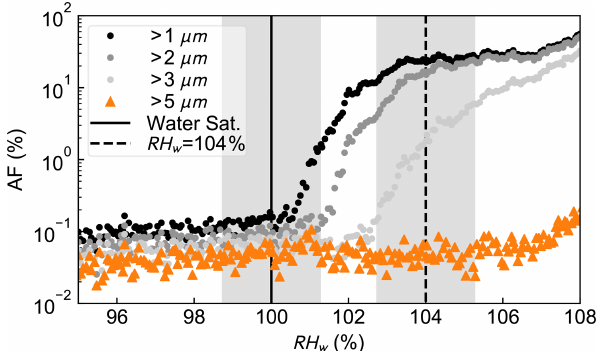
Figure B1. AF as a function of RH w at − 30 ◦ C for 200nm am- monium nitrate aqueous droplets detected in different HINC OPC channels. Vertical solid and dash black lines represent water satura- tion (RH w = 100%) and RH w = 104%, respectively. Grey shading indicates the average variation of RH w along HINC lamina center- line.